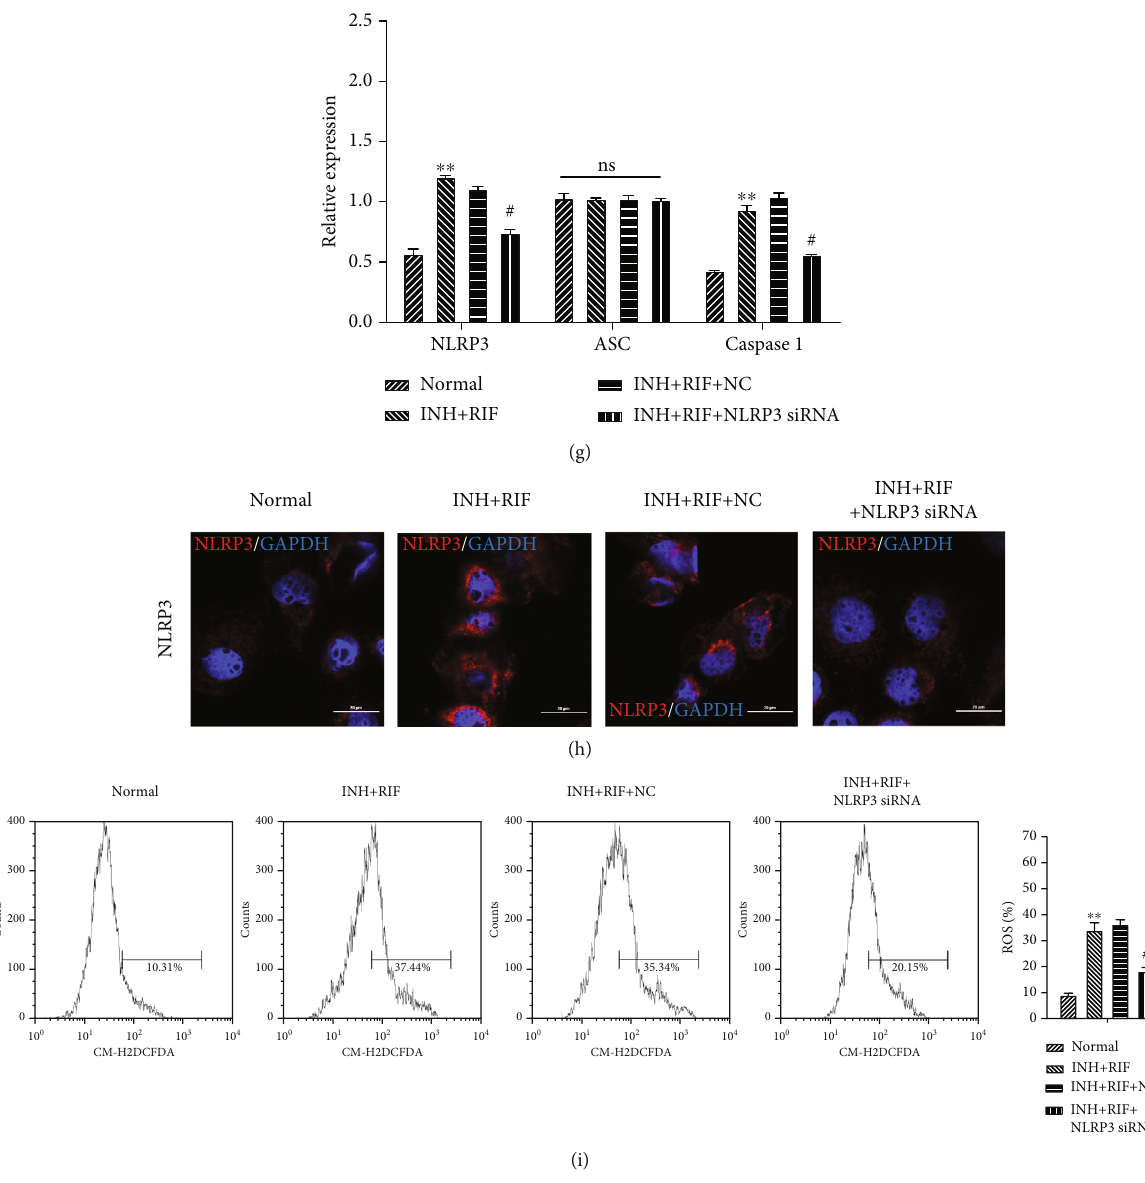
Figure 5: INH and RIF regulated drug-metabolizing enzymes and induced an in fl ammatory response and OS in hepatic cells by activating the NLRP3 in fl ammasome. Hepatic cells were treated with INH and RIF and then transfected with NLRP3 siRNA. (a) Transfection e ffi ciency of siRNAs was detected by using QRT-PCR. (b) QRT-PCR analyses were performed to detect the levels of NAT2 and CYP2E1 expression in each group of hepatocytes. ELISA assays were performed to detect the levels of IL-33 (c), IL-18 (d), and IL-1 β (e) in hepatic cells treated with INH and RIF, and INF39 or CP-456773. (f) Western blot analyses revealed changes in the levels of NLRP3, ASC. And cleaved-caspase 1 protein expression in the treated hepatic cells. (g) Protein expression was quanti fi ed based on the gray values obtained from western blotting. (h) IF assays were performed to determine the expression and distribution of NLRP3 protein in treated hepatic cells. Magni fi cation, × 200; scale bar = 20 μ m . (i) ROS levels were monitored by fl ow cytometry. ∗∗ P < 0 : 01 vs. the normal group; # P < 0 : 05 and ## P < 0 : 01 vs. the INH and RIF